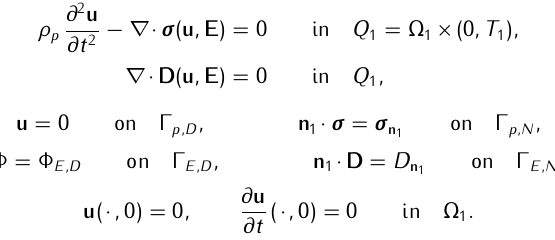
Since the frequency of the electromagnetic wave is small compared to the frequency of the generated acoustic wave, a coupling will be neglected. Further, the electric field will be considered as quasistatic and irrotational so that it can be expressed as the gradient of an electric potential Φ, i.e., E = −∇ Φ. Moreover, piezoelectric materials are nearly perfect insulators and hence, the only remaining quantity of interest in Maxwell’s equations is the dielectric displacement D which is related to the electric field by the constitutive equation D = ε E + P ,